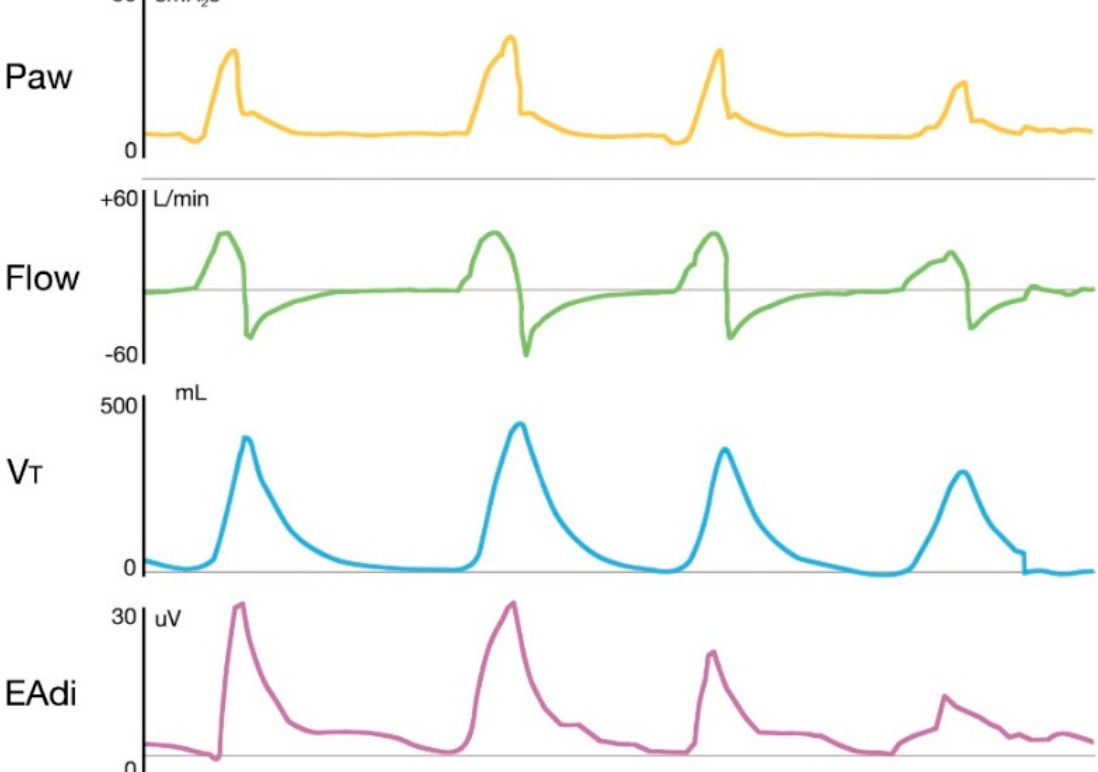
Figure 3. Representative tracings of airway pressure, flow, tidal volume and electrical activity of the diaphragm in a patient receiving NAVA. The figure shows how the pressure delivered by the ventilator is directly proportional to both EAdi and NAVA level, and the airway pressure-time outline accurately reflects the EAdi profile. Paw: Airway pressure; Vt: Tidal volume; EAdi: electrical activity of the diaphragm.